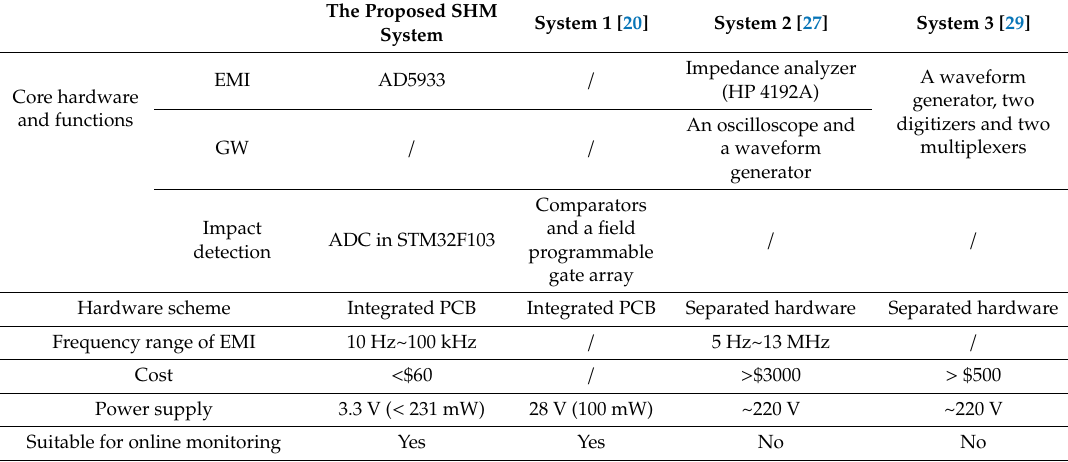
Table A1. Comparison of di ff erent structural health monitoring (SHM)